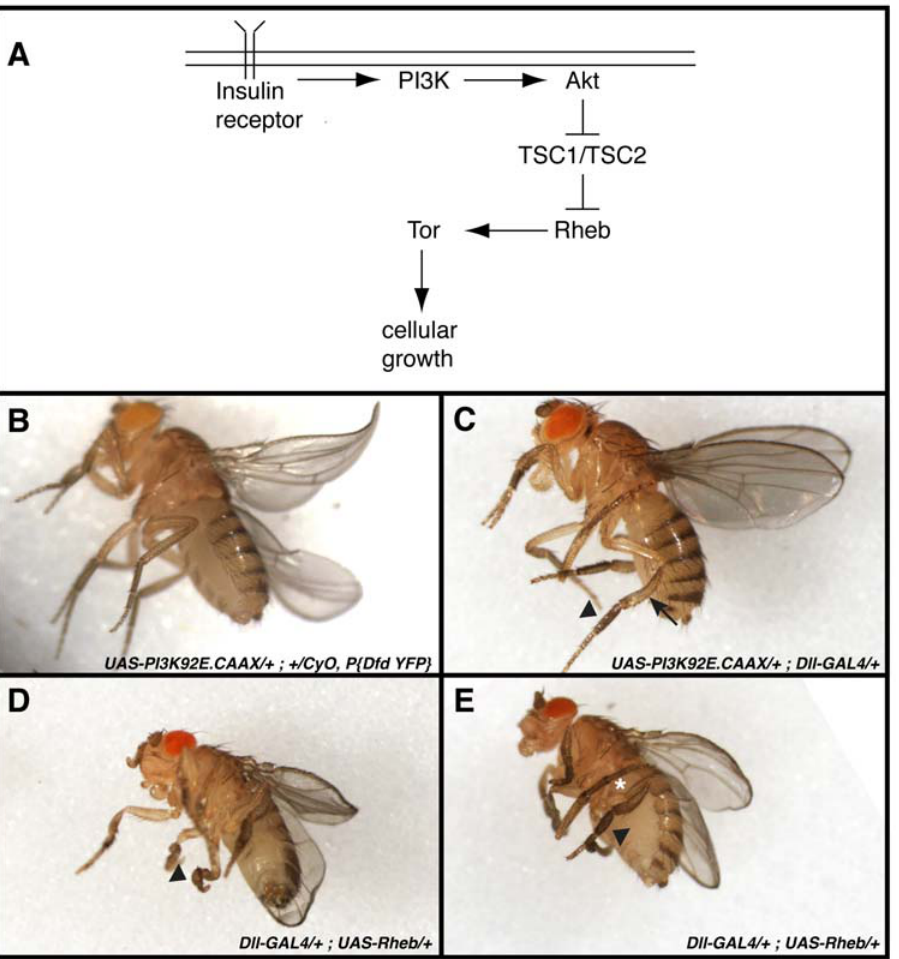
Figure 3. Overexpression of Rheb in distal leg segments results in a strongly penetrant malformed leg phenotype. (A) Model of the PI3K/Tor signaling pathway. Details of the pathway are found in the text. (B) Control animals, in this case heterozygous for UAS-PI3K92E.CAAX , but without a GAL4 driver, show normal leg morphology in live adults. Similarly, Dll-GAL4/ + and UAS-Rheb/ + adults have no leg malformations (not shown). (C) UAS-PI3K92E.CAAX/ + ; Dll-GAL4/ + animals express activated PI3K in distal leg segments (distal to the arrow) that results in a growth advantage giving the adults a ‘‘Popeye’’ leg phenotype. The most common morphogenesis defect is a slightly short, fat first tarsal segment (arrowhead). (D and E) Dll- GAL4/ + ; UAS-Rheb/ + adults show a highly penetrant malformed leg phenotype independent of the ‘‘Popeye’’ growth phenotype. Mild phenotypes include moderate to extreme short fat distal tibia and tarsal segments (arrowhead in E), whereas more extreme phenotypes include severely misshapen and twisted segments (arrowhead in D). The edges of the wings are often curved while the overall size of the wing is reduced. These defects are often accompanied by severe bends in the femur (white asterisk in E), even though the transgene is not expressed in this segment.